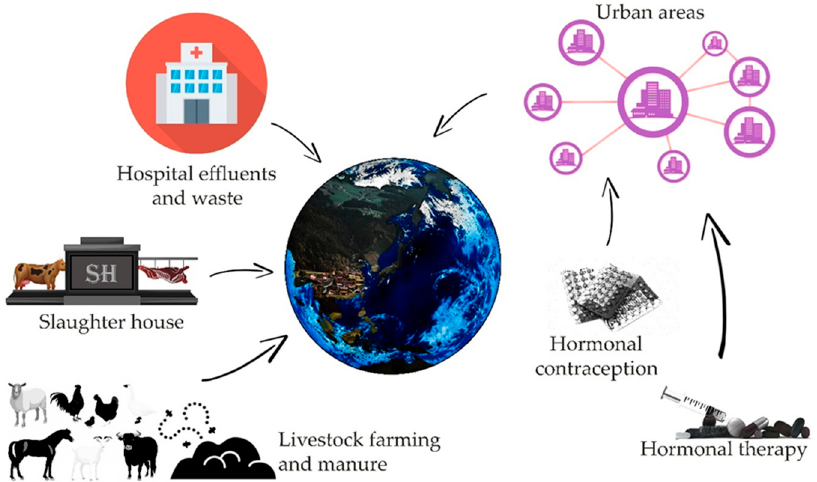
Figure 1. Sources of estrogens present in the environment and their simplified pathways leading to the environment (based on [4–8]) . the environment (based on